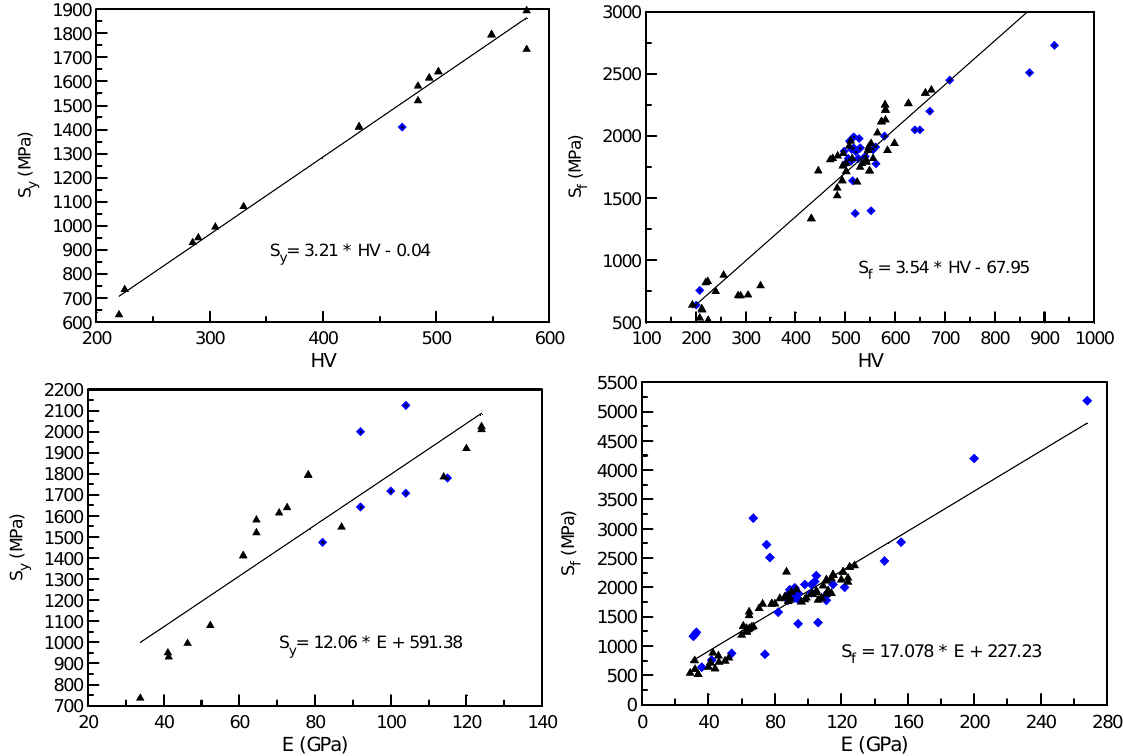
Figure 1. Correlation between mechanical properties of bulk metallic glasses. Here S denote Yield and Fracture Strength, respectively. Triangles denote ternary while S f diamonds quaternary